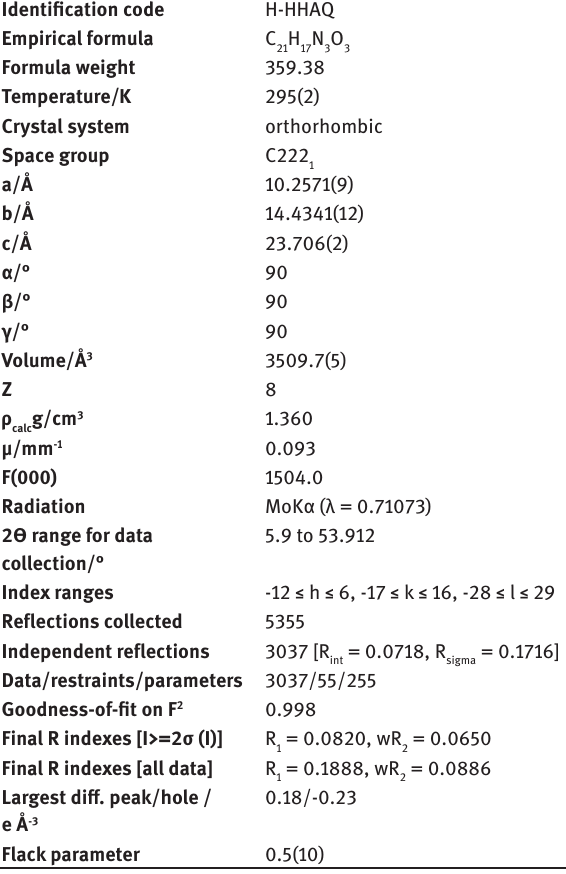
Table 1: Crystal data and structure refinement for H-HHAQ. Identification code